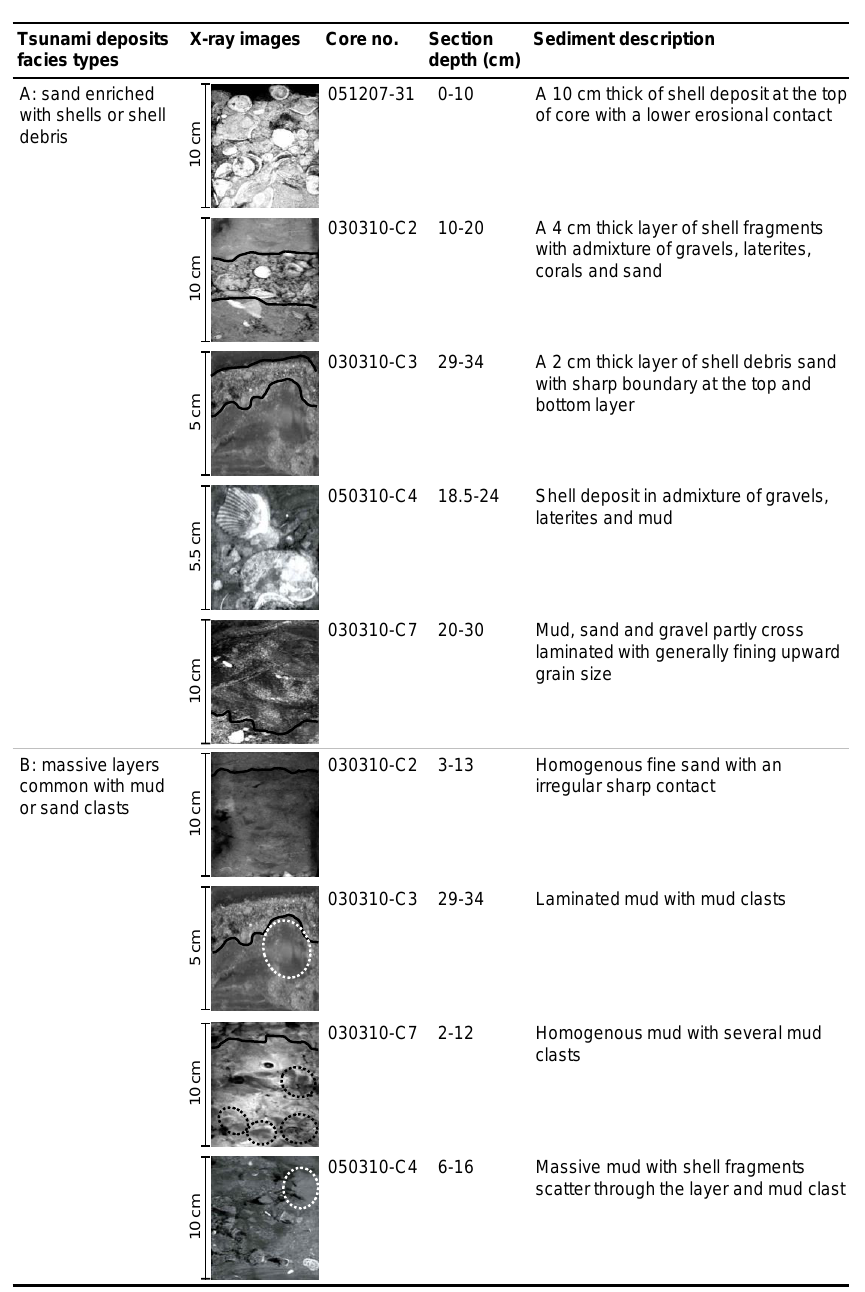
Table 4. Tsunami facies types. Table 4: Tsunami facies types.